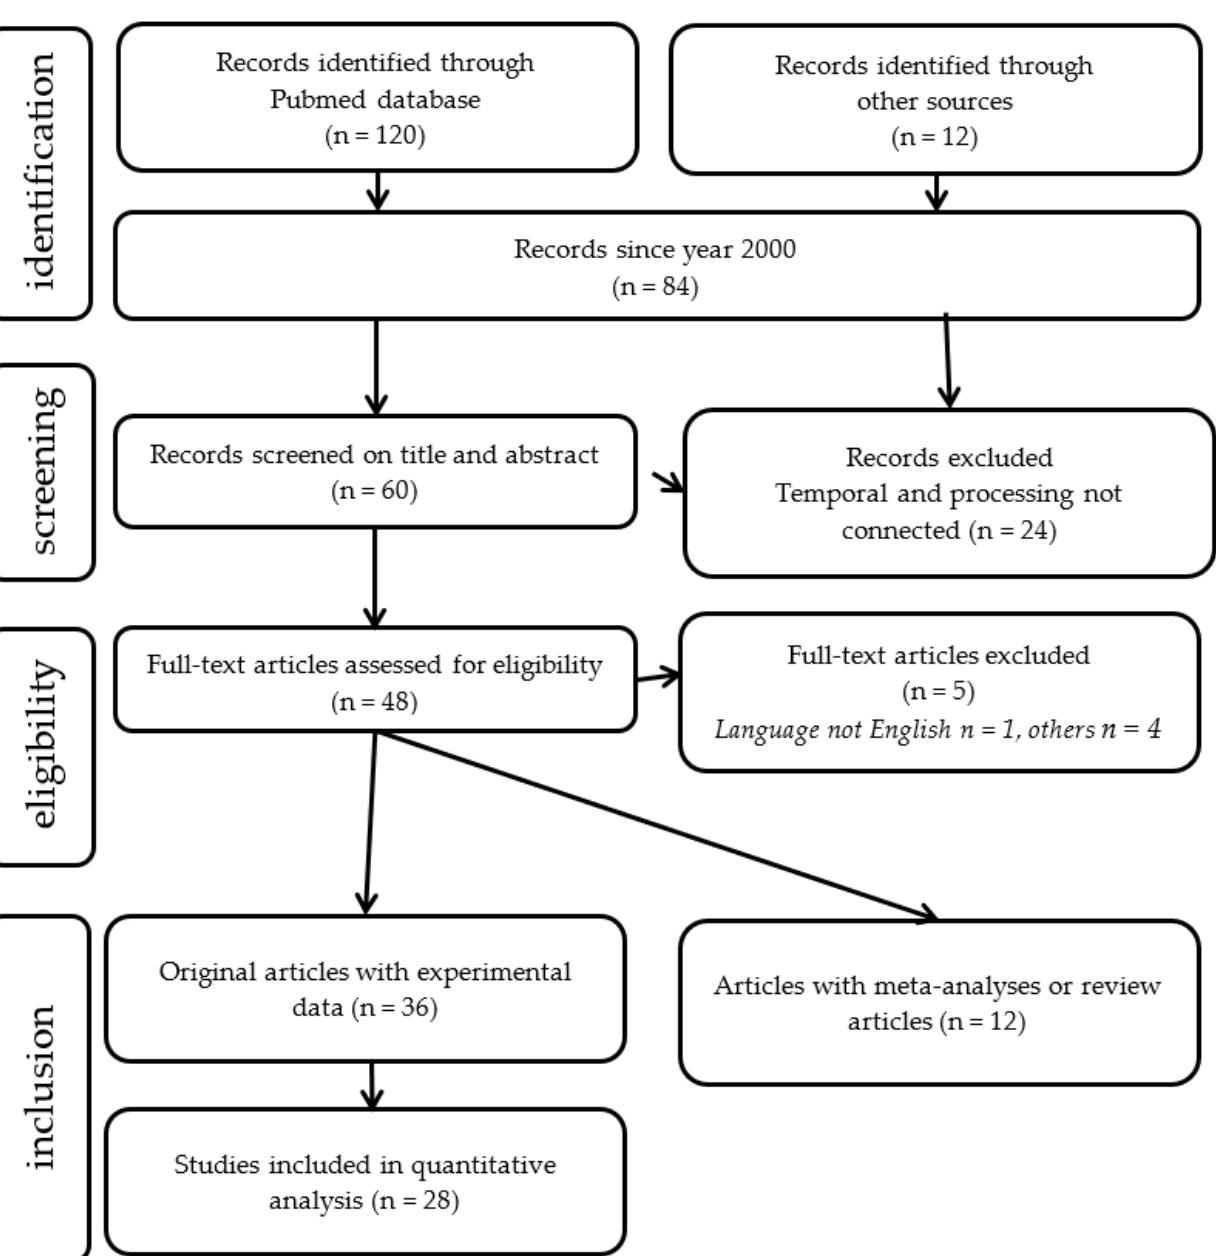
Figure 8. Search strategy: flowchart showing the number of included studies for the analytic and meta-analytic components of the review.